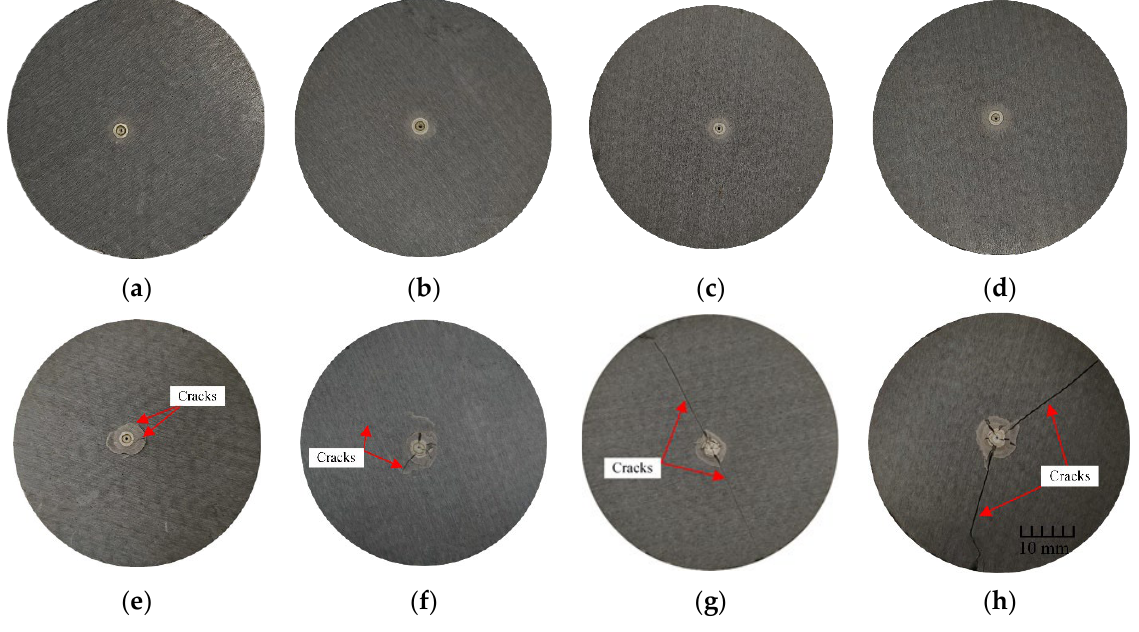
Figure 9. Surface morphology of dried sample after laser irradiation at a power of 90 W ( a ) 90 s; ( b ) 120 s; ( c ) 150 s; ( d ) 180 s; ( e ) 90 s after one month; ( f ) 120 s after one month; ( g ) 150 s after one month; ( h ) 180 s after one month.